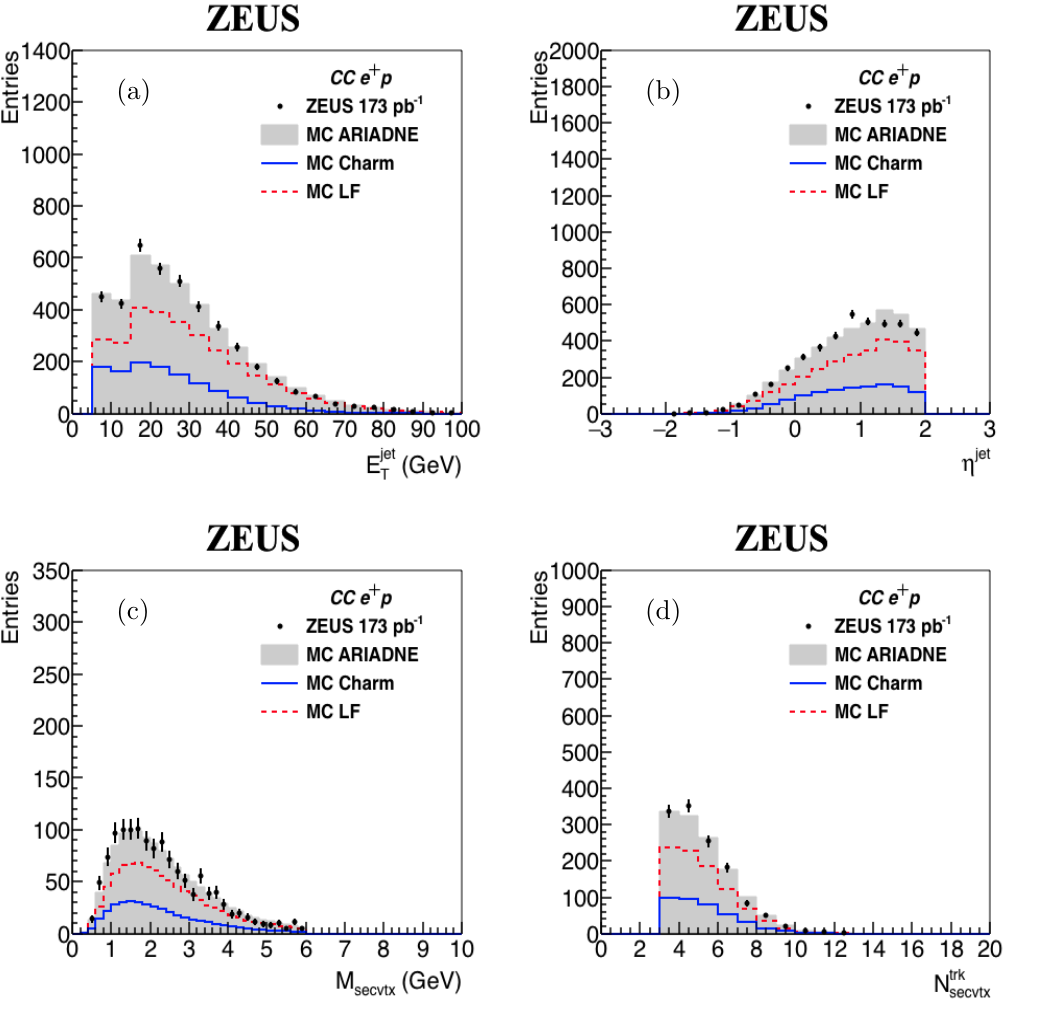
Figure 5. Comparison between data (points with vertical error bars) and MC (histogram) for jet and secondary-vertex distributions: (a) E jet The labels are the same as in (cid:12)gures 3 and